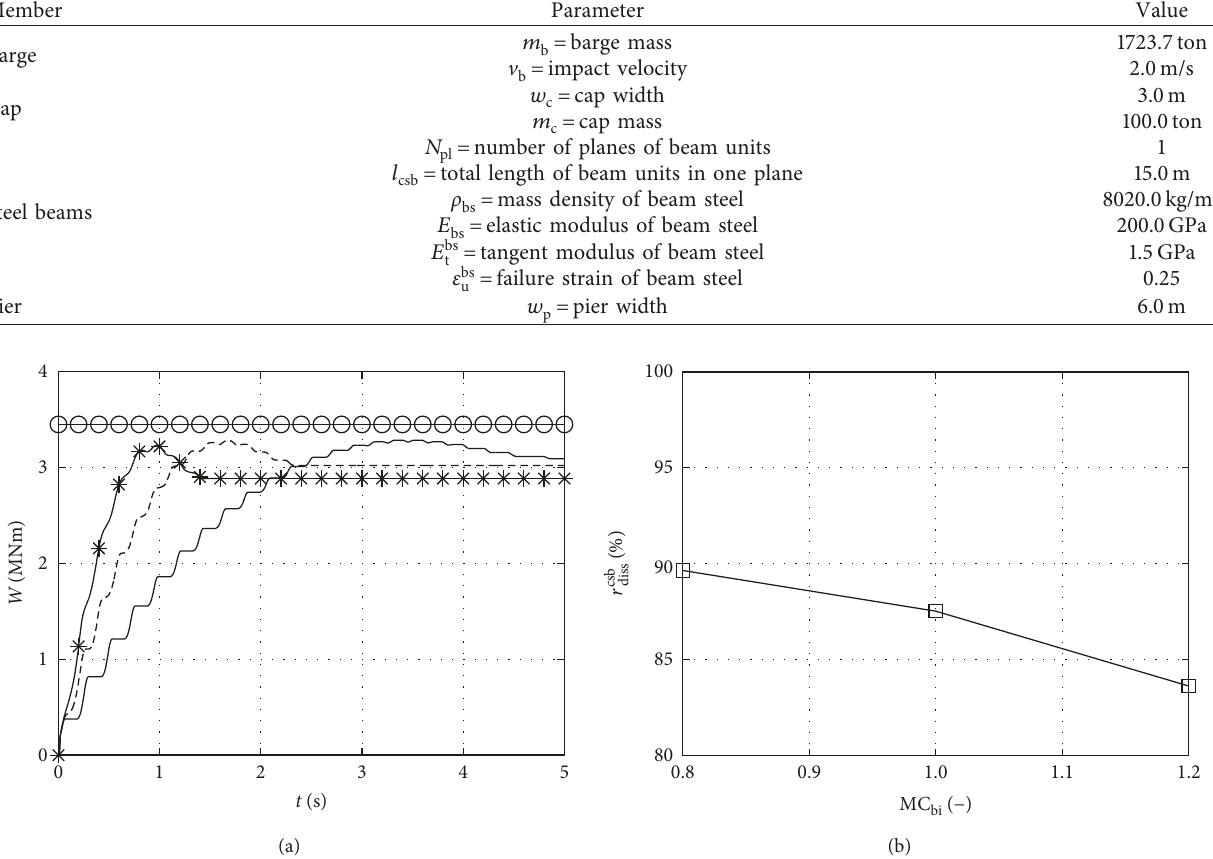
Figure 7: Time histories of energy absorbed by the device (a) corresponding to different beam cross-section dimensions and the ratio of energy absorbed by the device after impact to the total impact energy, respectively, versus MC bi